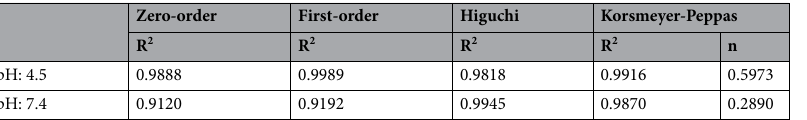
Table 3. Values of the correlation coefficient and release exponent obtained for mathematical models applied to DOX release from the BSG/chitosan nanocomposite of 2wt% BSG.